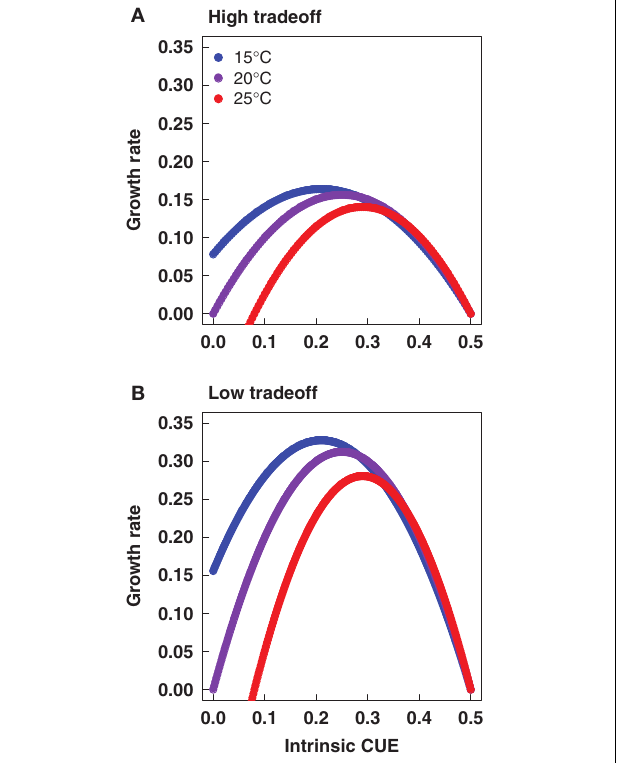
FIGURE 1 | Relative growth rate as a function of intrinsic carbon use efficiency (CUE) at different temperatures from the analytical model under the (A) high tradeoff ( m U = − 0 . 4) and (B) low tradeoff ( m U = − 0 . 2)